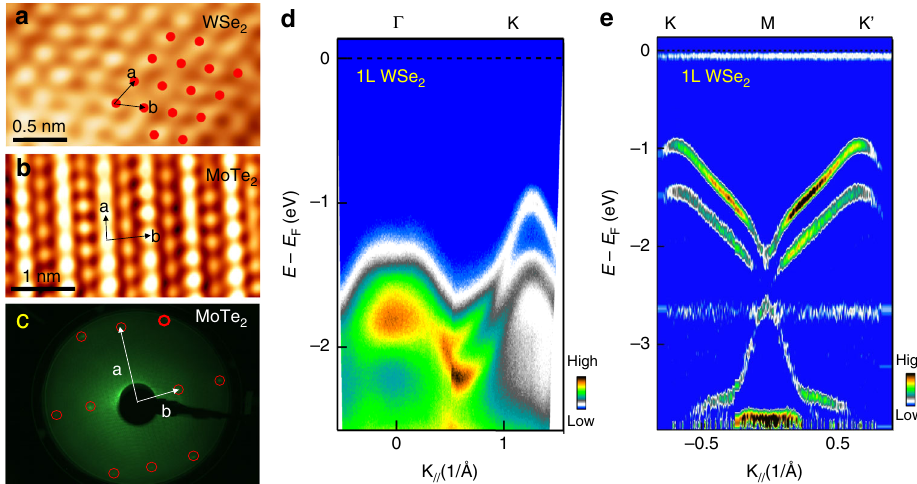
Fig. 3 STM and ARPES measurements of 2D materials exfoliated onto conductive Au/Ti adhesion layers. a , b STM images of monolayer WSe 2 and T d - MoTe 2 , respectively. c LEED pattern of monolayer T d -MoTe 2 . d , e Band structure of monolayer WSe 2 . d Original ARPES band structure of monolayer WSe 2 ( hv = 21.2 eV) along Γ -K high symmetry line. The valence band maximum (VBM) is positioned at K instead of Γ , which is an important signature of monolayer WSe 2 . e Second-derivative spectra of band dispersion along K – M – K ’ , showing clear spin-orbital coupling (SOC) induced spin-splitting bands.